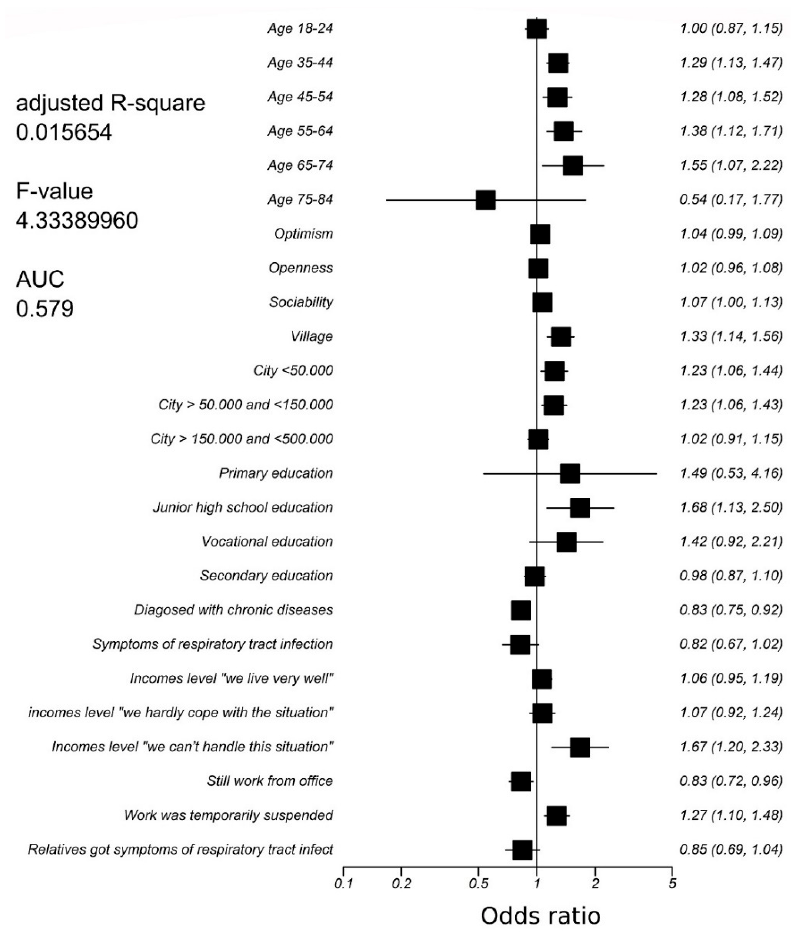
Figure 1. Results of multivariate logistic regression for stricter lockdown compliance.